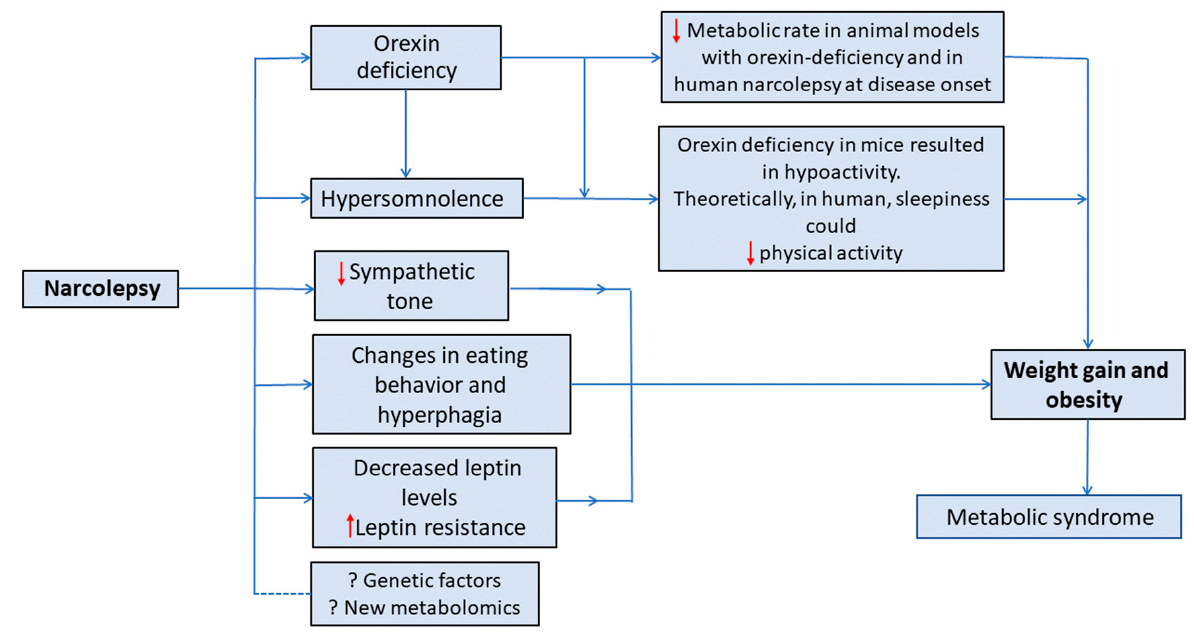
Figure 2. A summary of the proposed mechanisms for increased weight in patients with narcolepsy.